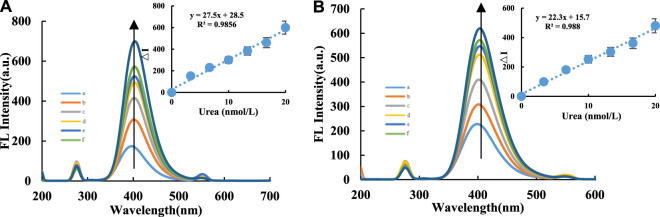
FL spectra of CD-H2O2-TMB analysis system. Without H2O2-TMB probe, A/B compared the fluorescence between CDFe and CDFeN in the urea analysis system. (A): CDFe-H2O2-TMB-Tris-HCl-Apt-Urea system. a: 0.04 μg/ml CDFe+ 6.7 μmol/L H2O2+ 0.03 mmol/L TMB+ 0.84 mmol/L PH = 4.4 Tris-HCl+16.65 nmol/L Apt; b: a+3.33 nmol/L Urea; c: a+6.66 nmol/L Urea; d: a+9.99 nmol/L Urea; e: a+13.32 nmol/L Urea; f: a+16.65 nmol/L Urea; g: a+20 nmol/L Urea; (B): CDFeN-H2O2-TMB-Tris-HCl-Apt-Urea system, a: 0.04 μg/ml CDFeN+6.7 μmol/L H2O2+0.03 mmol/L TMB+ 0.84 mmol/L PH = 4.4 Tris-HCl+16.65 nmol/L Apt; b: a+3.33 nmol/L Urea; c: a+6.66 nmol/L Urea; d: a+9.99 nmol/L Urea; e: a+13.32 nmol/L Urea; f: a+16.65 nmol/L Urea; g: a+20 nmol/L Urea.